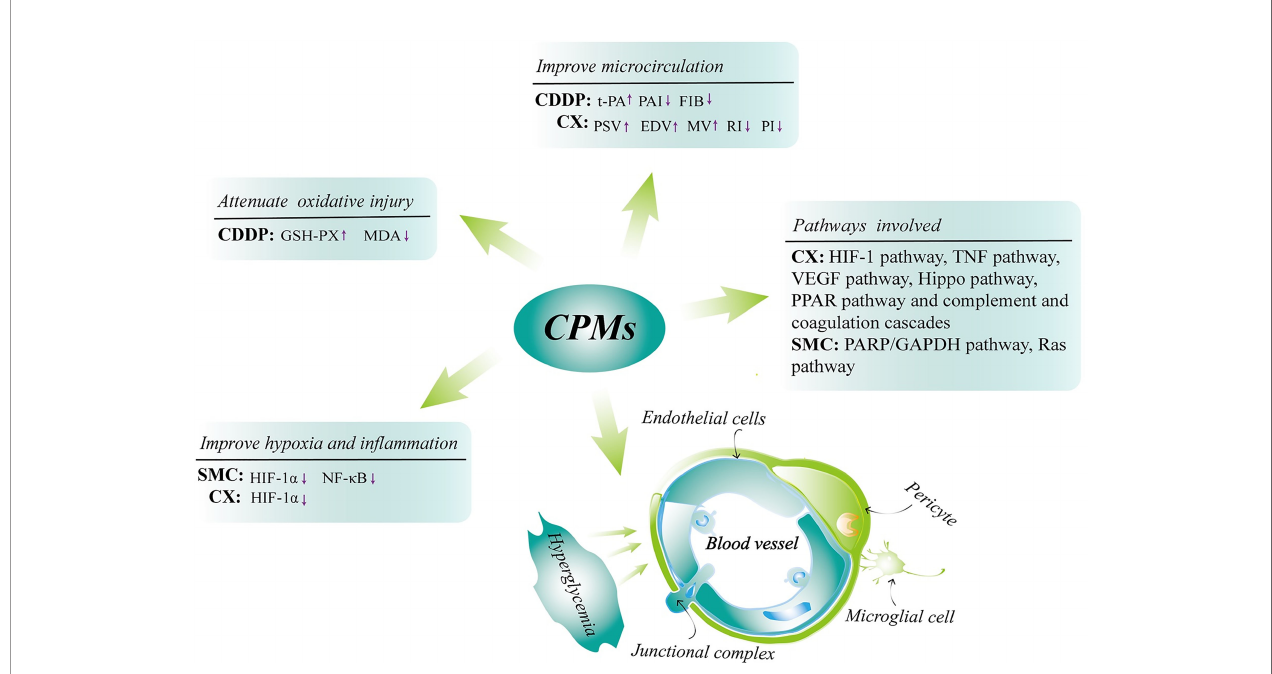
FIGURE 10 | The major underlying mechanisms involved in the treatment of DR with CPMs (CX, CDDP and SMC). Chinese patent medicines (CPMs); Compound Xueshuantong (CX); Compound Danshen Dripping Pill (CDDP); Shuangdan Mingmu Capsule (SMC); tissue plasminogen activator (t-PA); plasminogen activator inhibitor (PAI); fi brinogen (FIB); peak systolic velocity (PSV); end diastolic velocity (EDV); mean velocity (MV); resistance index (RI); pulsatility index (PI); glutathione peroxidase (GSH-PX); malondialdehyde (MDA); hypoxia-inducible factor 1 a (HIF-1 a ); nuclear factor- k B (NF ‐ k